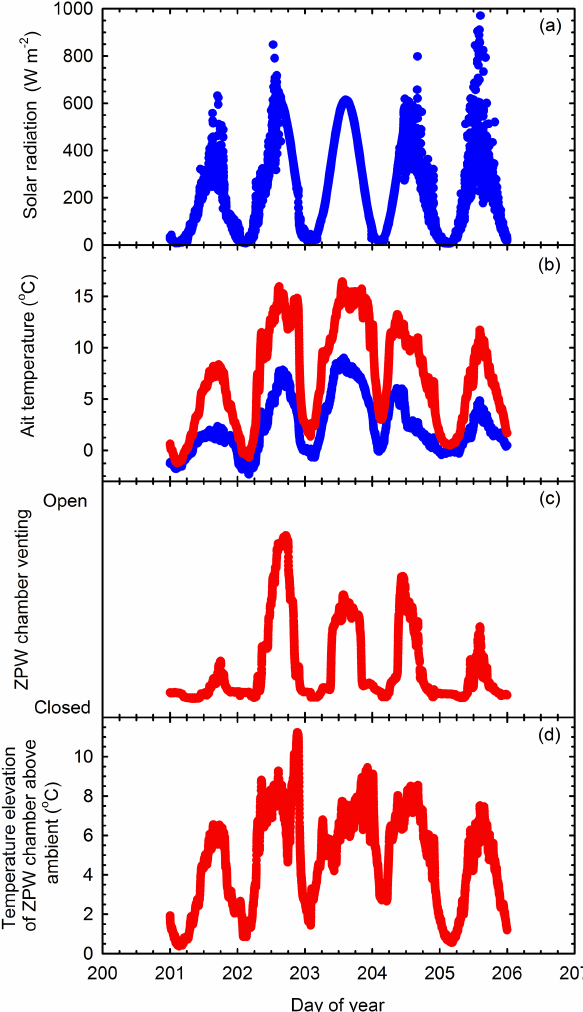
Figure 3. A sample time series of ZPW performance. Energy for warming comes from ambient solar radiation shown in (a) ; (b) shows the air temperature in the ambient plot (blue) and inside ZPW chamber (red); (c) shows the degree to which the vents opened due to the temperature differential between the internal and external heat exchangers as measured by a string potentiometer connected to the edge of the vent; (d) shows the air temperature differential be- tween the ZPW and the ambient plot. Plots show 1min